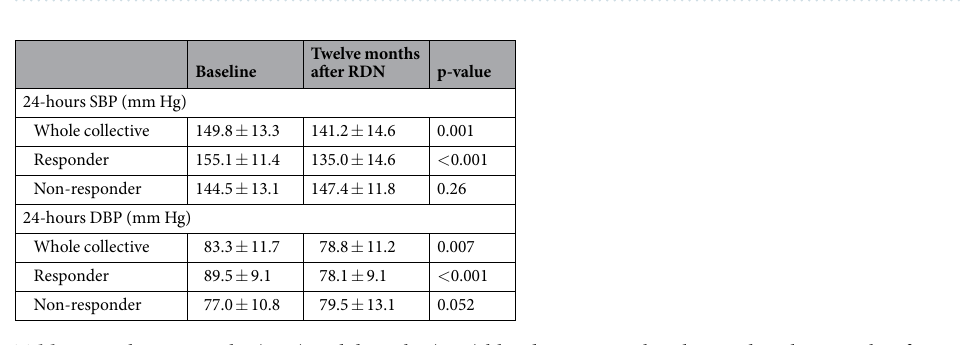
Table 3. 24-hours systolic (SBP) and diastolic (SBP) blood pressure at baseline and twelve months after renal